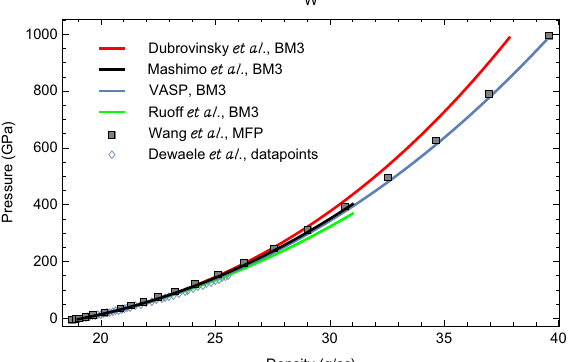
Figure 7. The T = 0 equation of state of bcc-W: our own ab initio calculations using VASP vs. experimental data (Dubrovinsky et al. [44]; Ruoff et al. [50]; Dewaele et al. [52]; and Mashimo et al. [53]) and other theoretical calculations (Wang et al.